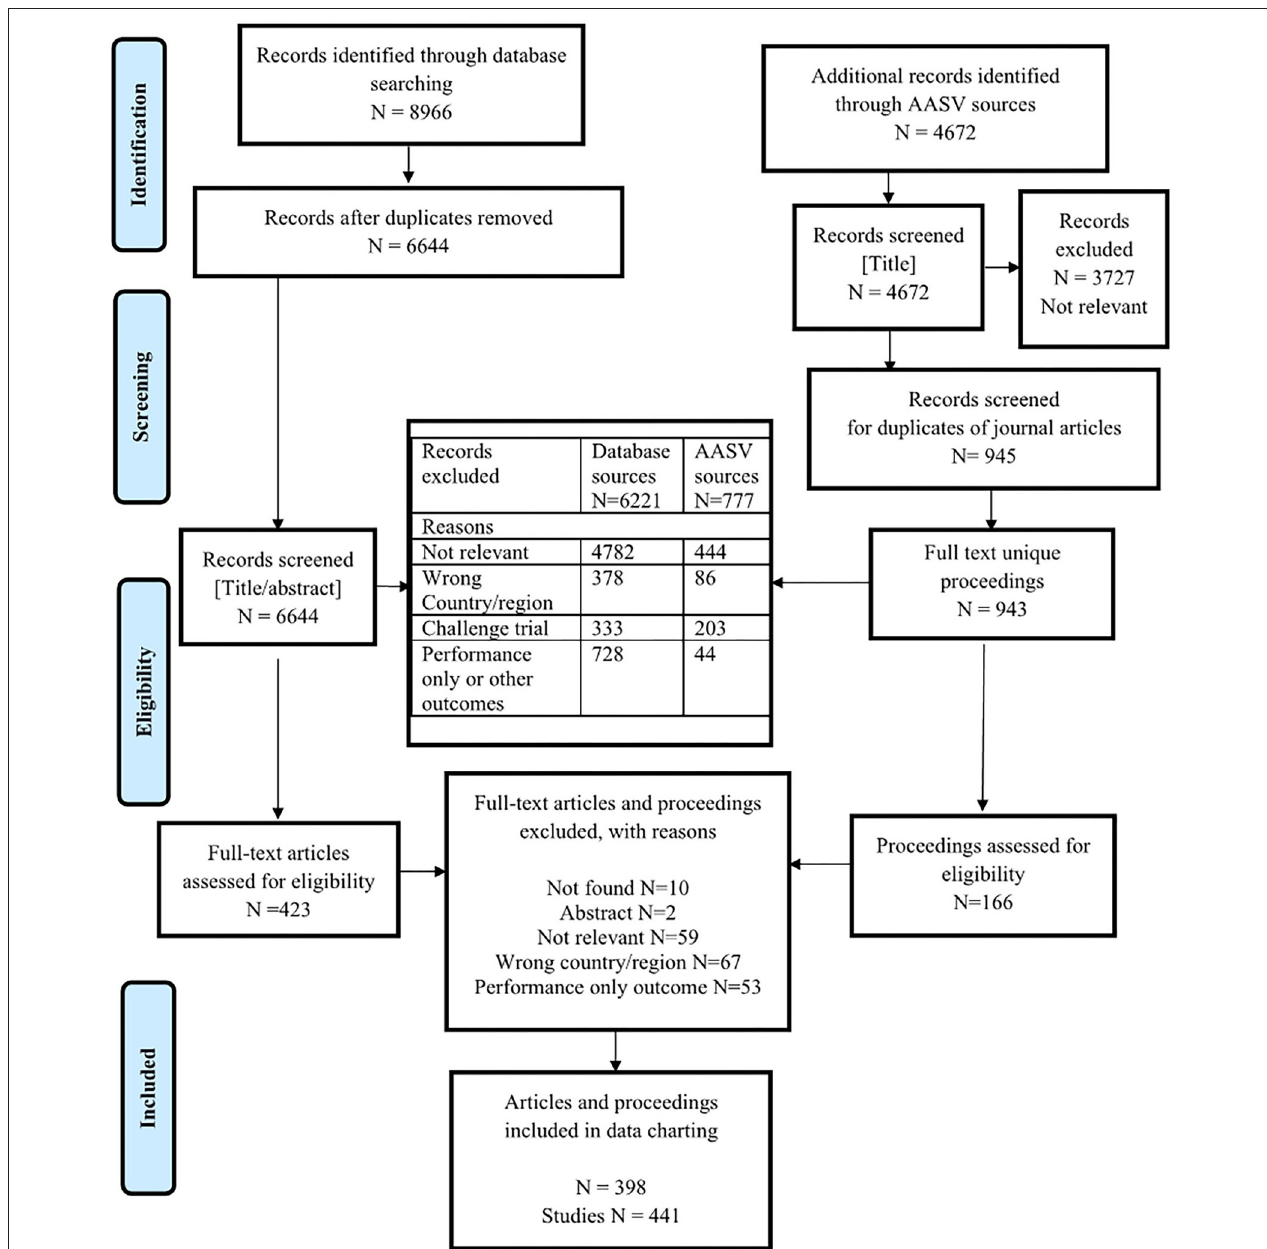
FIGURE 1 | Preferred Reporting Items for Systematic Reviews and Meta-Analyses (PRISMA) flow diagram of citations from literature search through to relevance screening and data extraction. Data charted regarding the purpose(s) of the intervention were based on information in the title or objective